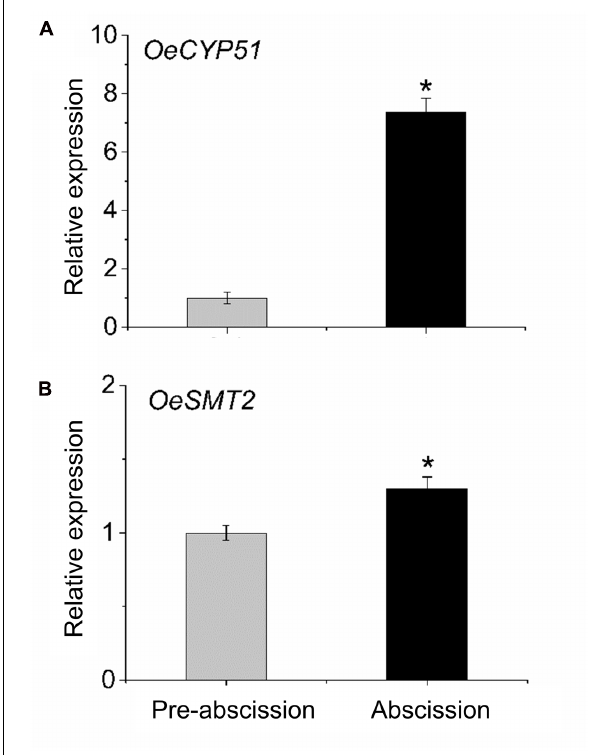
FIGURE 6 | Transcript analysis by real-time PCR of (A) OeCYP51 and (B) OeSMT2 mRNAs in olive AZ during mature-fruit abscission. Total RNAs were isolated from olive-fruit AZs at two different stages (pre-abscission and abscission) and subjected to q RT-PCR analysis using Olea europaea ubiquitine as an internal control. The data represent the mean values ( ± SE) of duplicate experiments from three independent biological samples. Statistically significant differences based on unpaired Student’s t -test at P < 0.05 are denoted by asterisk.